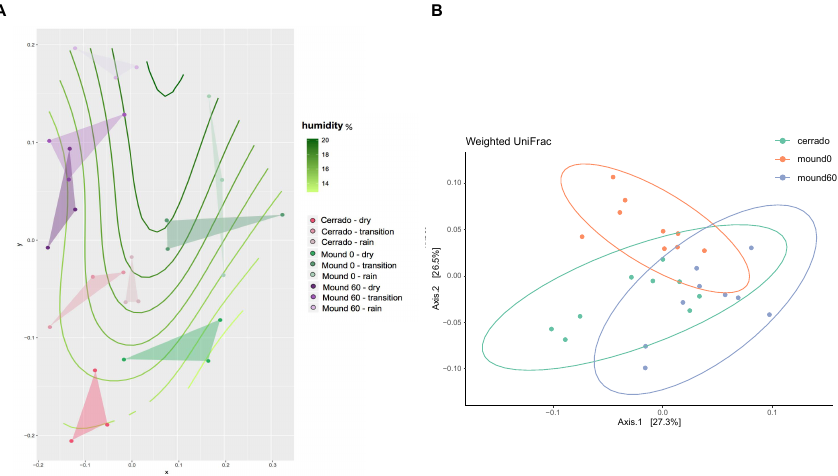
Figure 4. Non-metric dimensional scale analysis from the Cerrado soil samples (50–60 cm), mound surface (0–10 cm), and mound soil (50–60 cm) at the dry, transition, and rainy seasons. ( A ) Non-Metric Multidimensional Scaling (NMDS) of the bacterial community in regard to soil moisture content. Data from the bacterial Operational Taxonomic Unit (OTU) matrix was distributed according to the Bray–Curtis dissimilarity analysis and disposed with its respective soil sample humidity measure. ( B ) The weighted Unifrac matrix analysis displays the sites of the Cerrado soil in green, mound surface in orange, and mound soil in